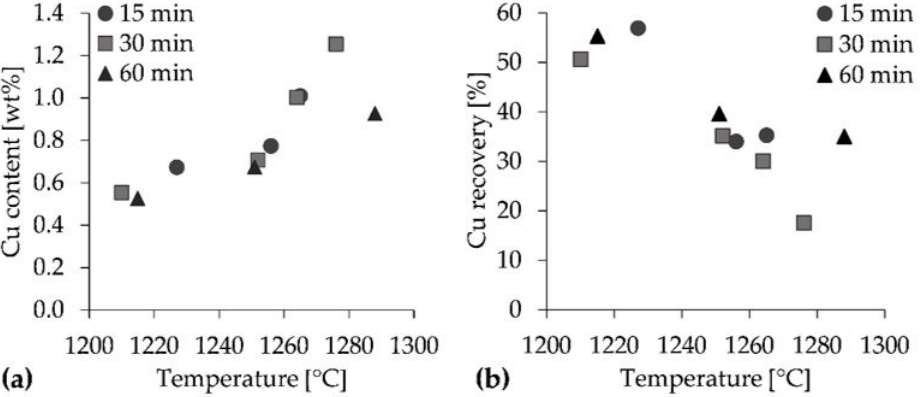
Figure 3. ( a ) The copper content of water-granulated slag as a function of temperature for batch T1–T10; ( b ) the copper recovery in the settling furnace versus the temperature.